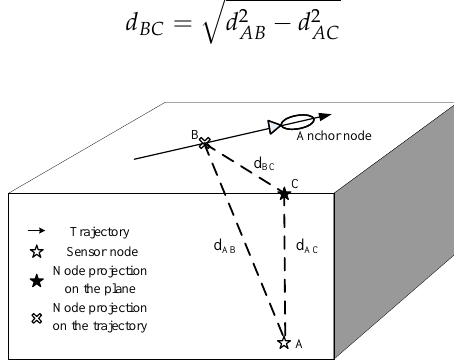
Figure 9. Transforming 3D localization into 2D